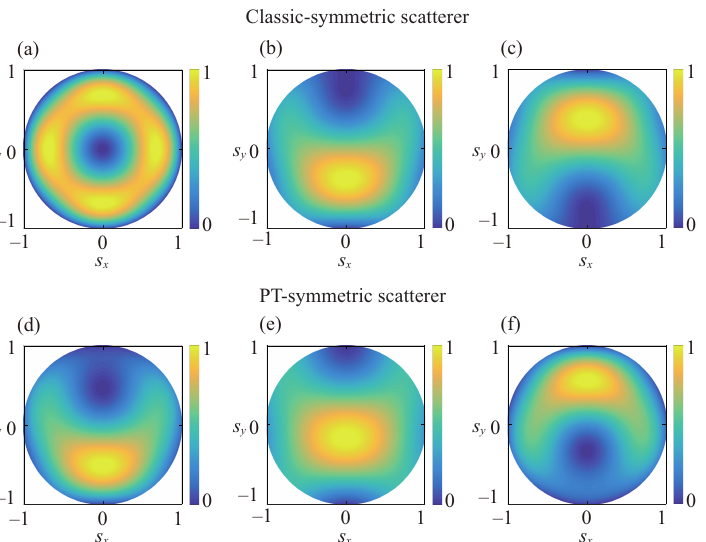
Figure 6. Simulation results for the total intensity Λ 0 ( r s , ω ) of the far-zone scattered field generated by scattering the partially coherent radially polarized beam having degree of coherence shown in Equation (39) with a four-point scatterer having ( a – c ) classic-symmetric potential ( σ = 1 and γ = 0) and ( d – f ) PT-symmetric potential ( σ = 2 and γ = 1). The coherence parameters in ( a , d ) are α 1 = α 2 = α 3 = 1 and β 1 = β 2 = β 3 = 0, in ( b ) and ( e ) are α 1 = β 2 = α 3 = 0 and β 1 = α 2 = β 3 = − 1, and in ( c , f ) are α 1 = β 2 = α 3 = 0 and β 1 = α 2 = β 3 =